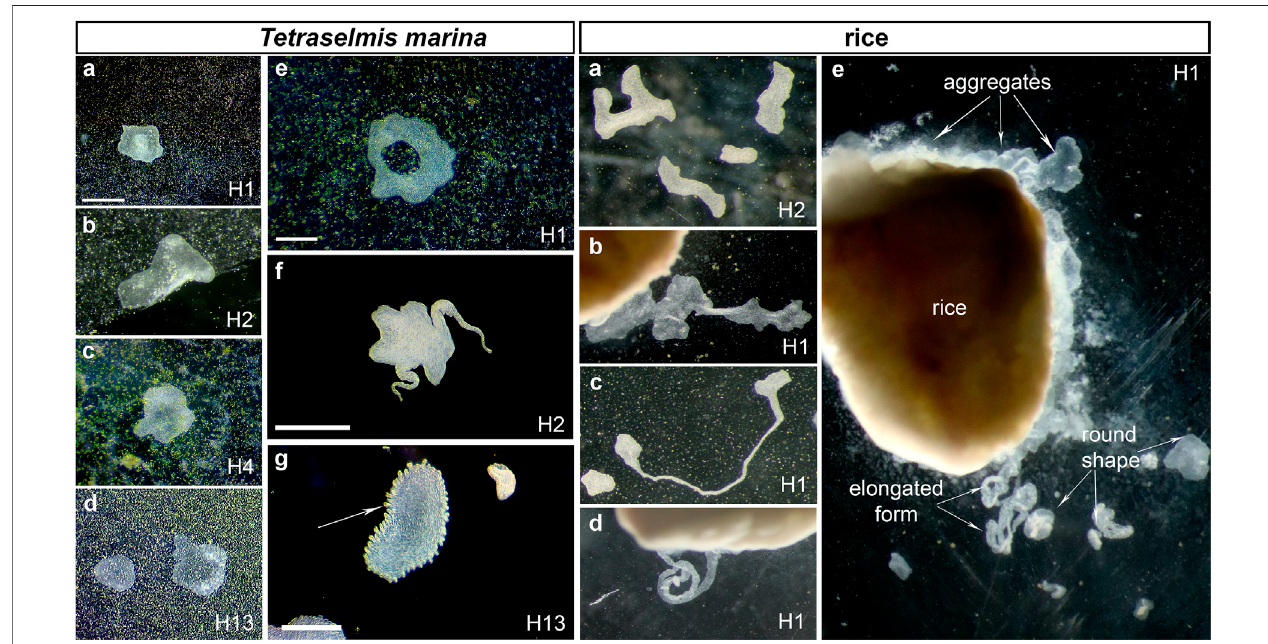
FIGURE 1 | The diversity of placozoan body forms. Illustrated examples from long-term culturing of different haplotypes (indicated in each photo) on two feeding substrates ( Tetraselmis marina and Riceboxes). Tetraselmismarina box showsboth canonical placozoans bodyshapes (A – D) andunusualmorphologies(animals with a “ hole ” inthemiddleofthebody( E and SupplementaryVideoS1 ),elongated “ pseudopodia ” -likestructures( SupplementaryFigureS3 ),andanimalswithnumerous small ovoid formations in the rim area (G) . The ‘ rice box ’ illustrate examples of different body morphology in cultured placozoans using different feeding substrate. Rice grains support a stable population growth rate but often facilitate the formation of aggregations of animals around grains (rice box A – D : different shapes of placozoans (A – B) , including those with highly elongated forms C,D ). Scale bar: Tetraselmis marina box: 500 μ m; Rice box: grain: 1 mm.